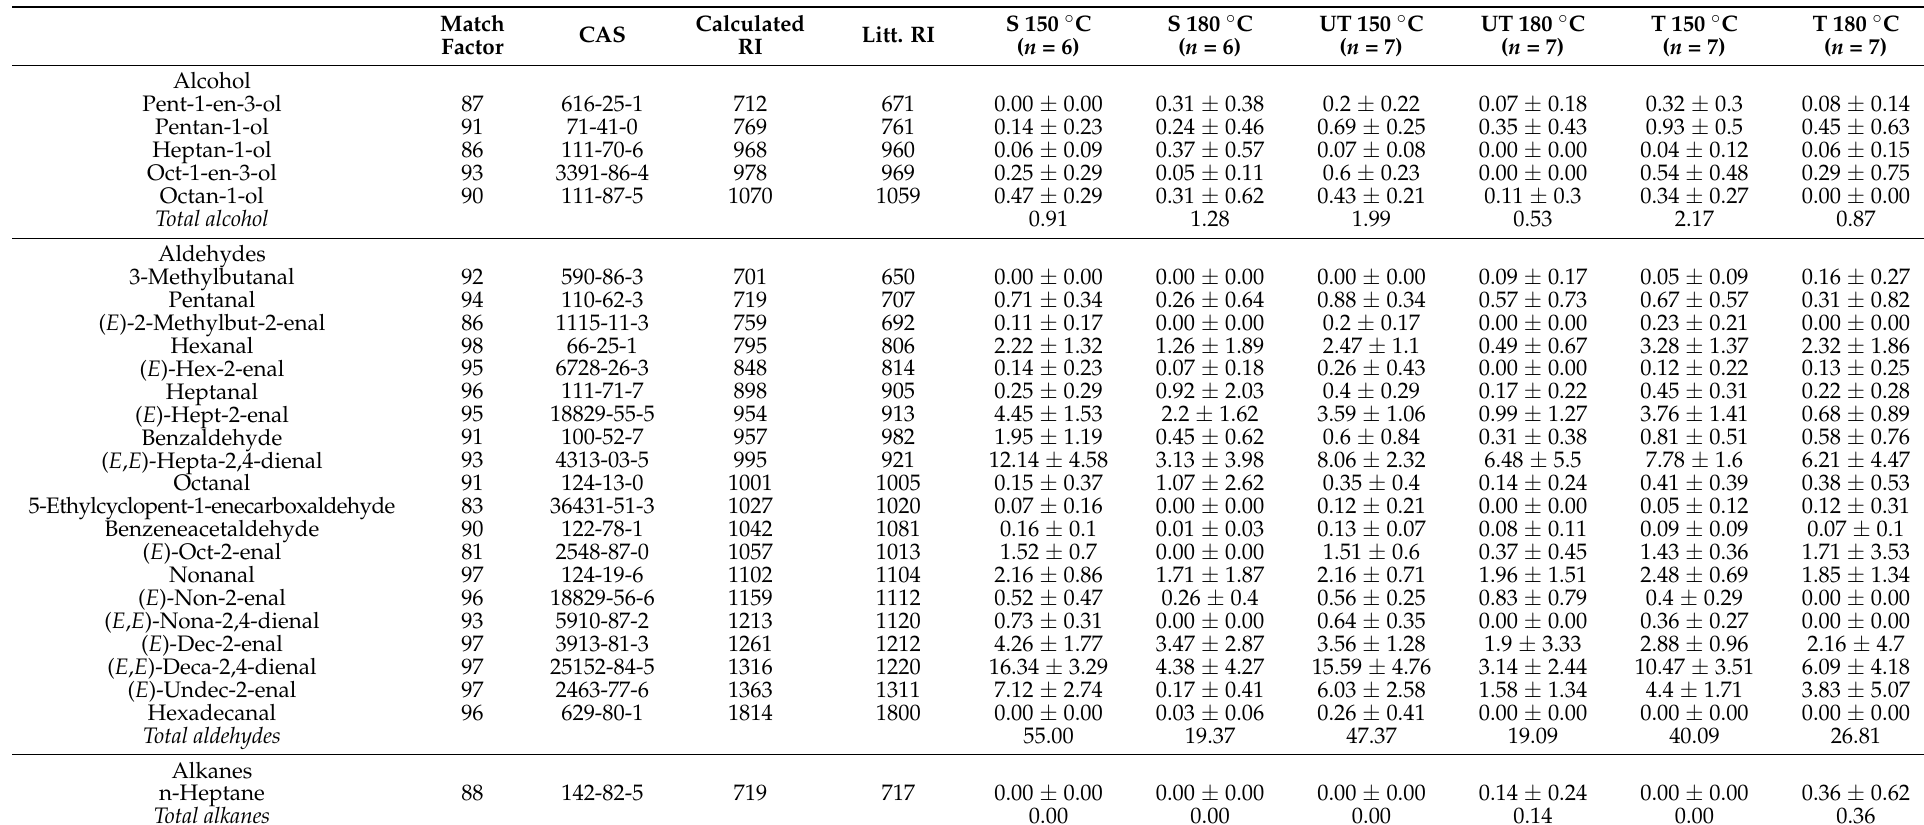
Table 2. GC-MS results of VOCs found in the headspace of heated fat. Results are expressed in relative abundance (%, mean ± s.d.). For each molecule, general information such as the match factor of the molecule when compared to the database, its CAS number, as well as the calculated RI and literature RI (NIST17) are given. Finally, relative abundance (%) is given for the six modalities tested: sow back fat heated at 150 ◦ C (S 150 ◦ C) and 180 ◦ C (S 180 ◦ C), untainted back fat heated at 150 ◦ C (UT 150 ◦ C) and 180 ◦ C (UT 180 ◦ C), as well as tainted back fat heated at 150 ◦ C (T 150 ◦ C) and at 180 ◦ C (T 180 ◦